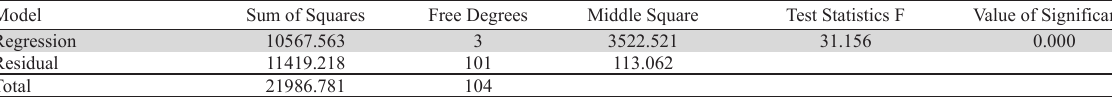
Structural Model Simultaneous Test Results 2